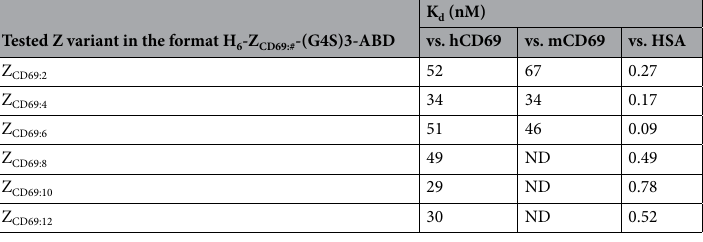
Table 1. Affinity constants for tested Z variants from SPR.